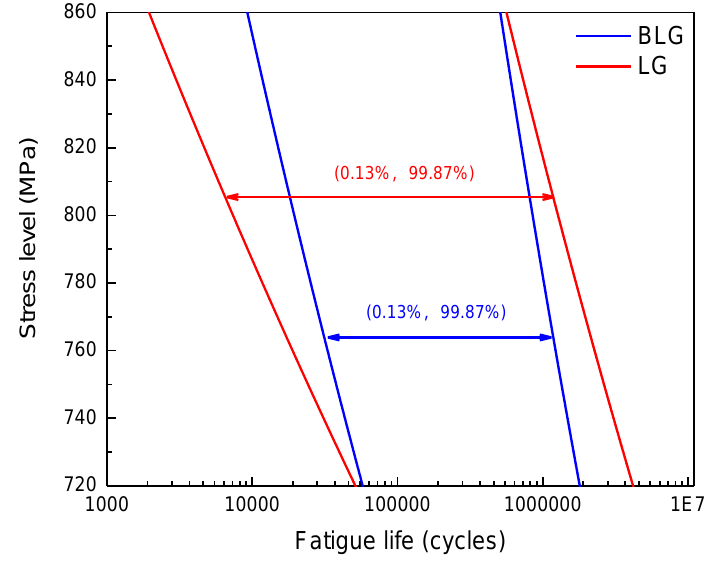
Figure 13. Variation of P-S-N curves based on an LG and BLG. Table 5. Parameters of the P-S- N curve based on an LG.